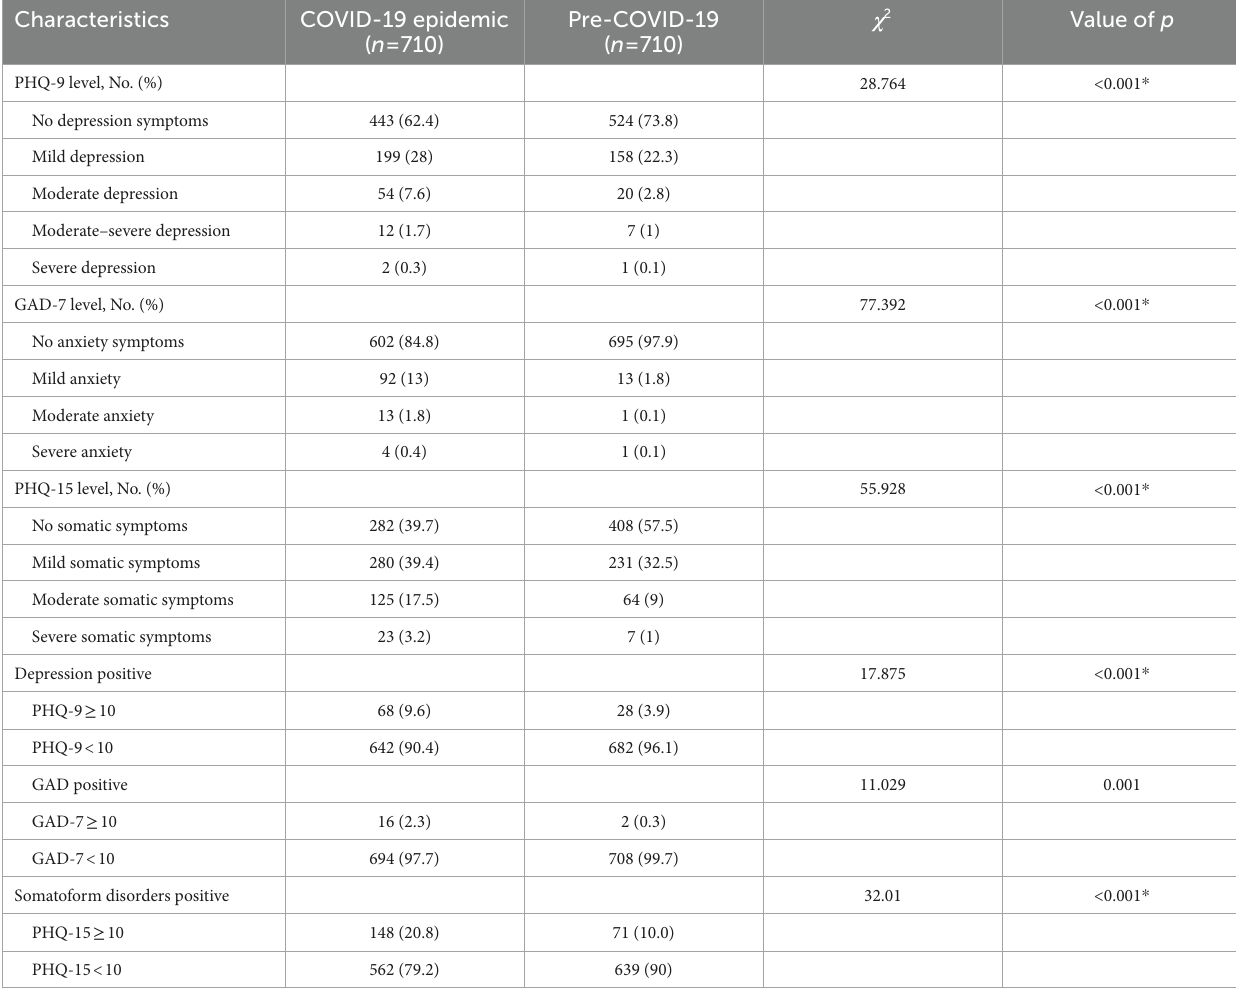
TABLE 4 Results of PHQ-9, GAD, and PHQ-15 between the two matched groups.